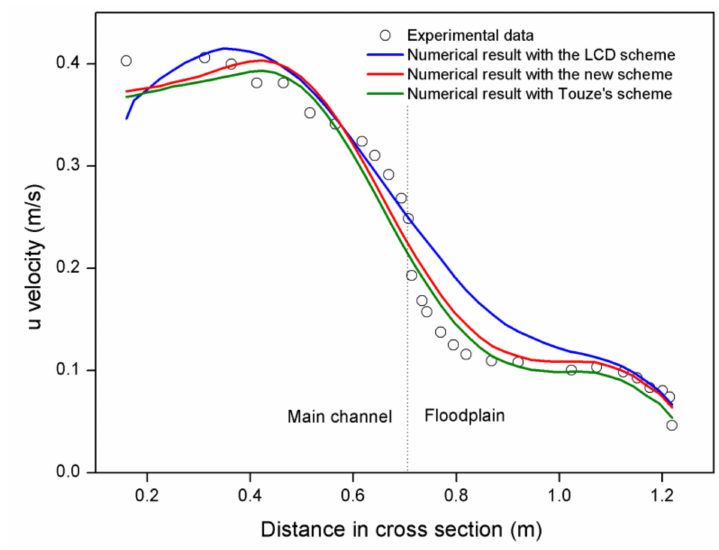
Figure 19. Comparison of experimental and simulated longitudinal velocities.